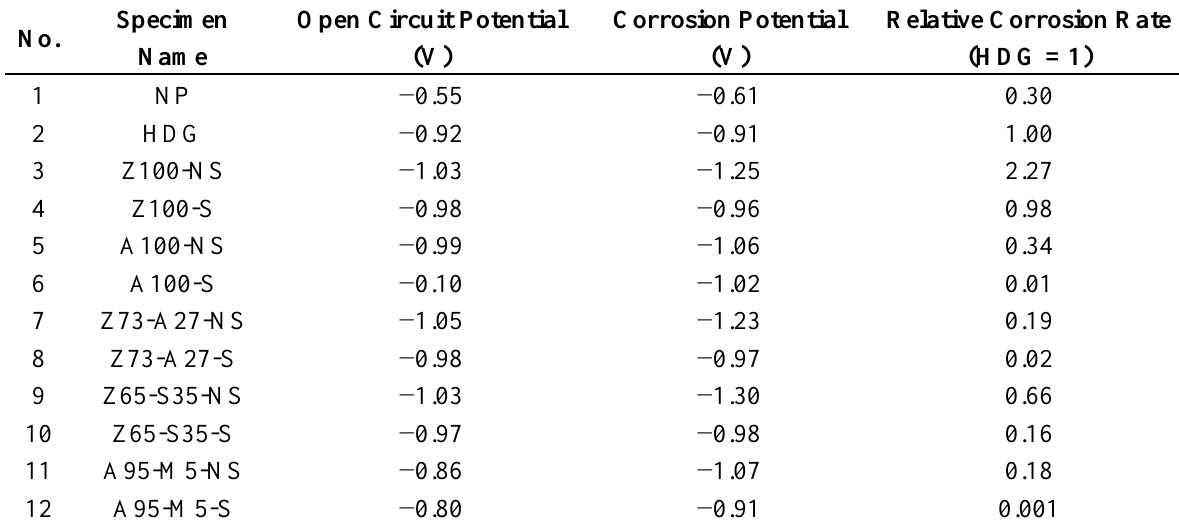
Table 3. Electrochemical test